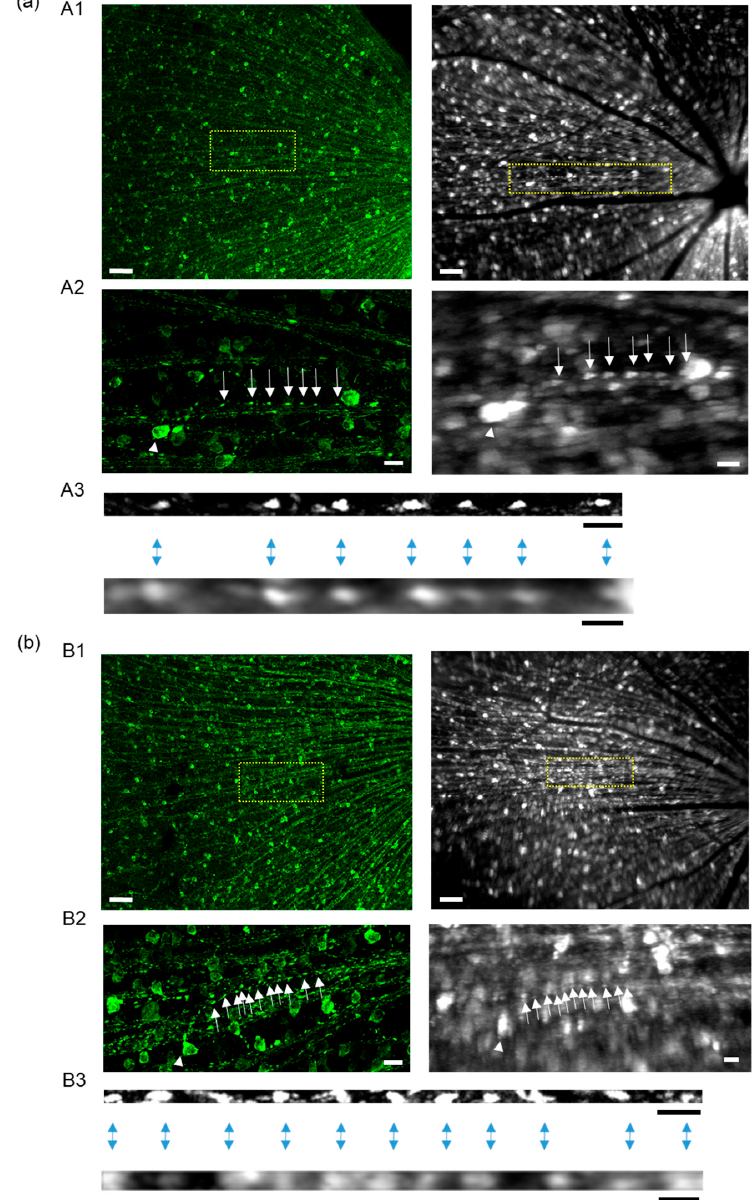
Figure 6. Comparison of mitochondrial distribution within a single axon by in vivo cSLO fundus imaging and by the in vitro imaging of flat-mounted retinal sections with confocal microscopy. ( a ) An example of the comparison between these two images. ( b ) Another example of a comparison. Mitochondria (YFP) shown in green in fundus images taken with cSLO and in white in images of flat-mounted retinal sections taken with a confocal microscope. Bars, 100 μ m in the left panels and 100 pixels in the right panels in A1 and B1, 20 μ m in the left panels and 20 pixels in the right panels in A2 and B2, and 10 μ m in the left panels and 10 pixels in the right panels in A3 and B3. Images of flat-mounted retinal sections taken with a confocal microscope are exhibited in the left panels in A1 and B1. Fundus images of mitochondria taken with cSLO are exhibited in the right panels in A1 and B1. The yellow squares in A1 and A2 are enlarged in B1 and B2. White arrows and arrowheads indicate a single mitochondrion and cell body, respectively. Mitochondrial distribution in linearized axons in flat-mounted retinal sections captured with confocal microscopy are exhibited in the upper panels of A3 and B3, and those in fundus images captured with cSLO are exhibited in the lower panels in A3 and B3. Mitochondria (YFP) shown in white in A3 and B3. Blue two-headed arrows indicate the corresponding mitochondria in the